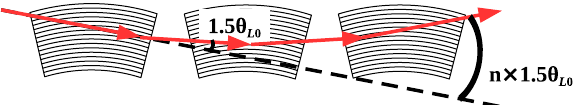
FIG. 4. Volume reflection in a sequence of bent